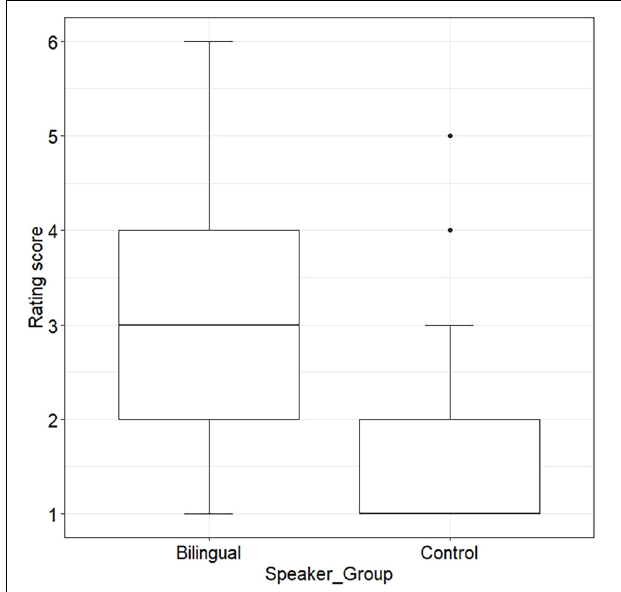
FIGURE 1 | Distribution of nativeness rating scores from 1 = certain of native speaker status to 6 = certain of non-native speaker status by speaker group (Bilingual vs.